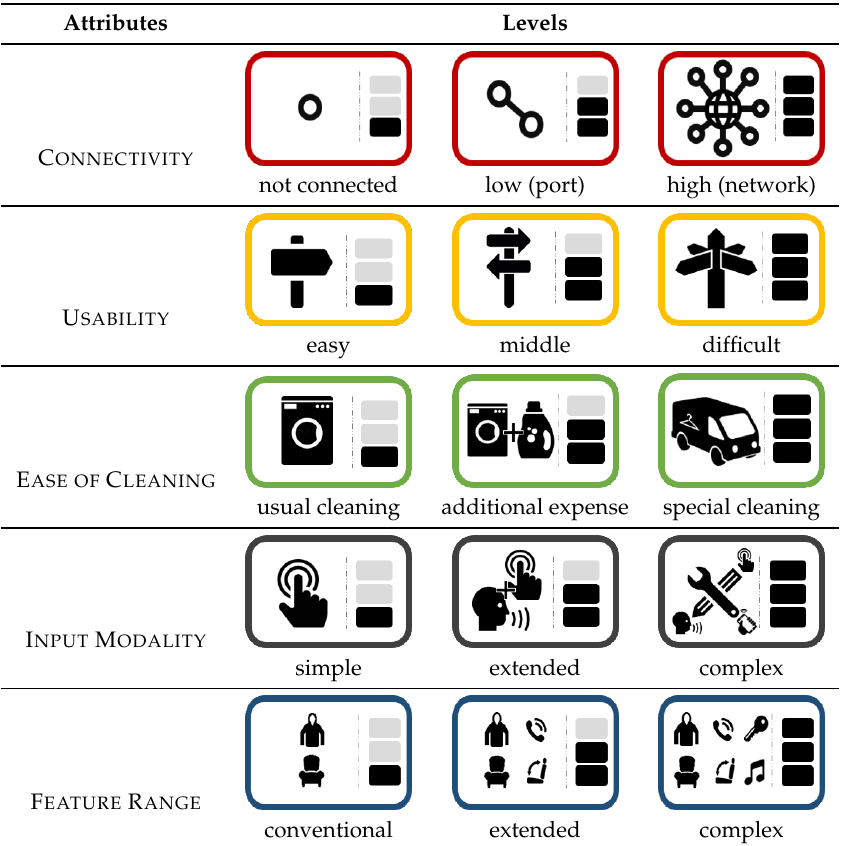
Table 1. Visualization of all attribute levels. A decision task consists of one level form each attribute. Each participant performed 7 choice